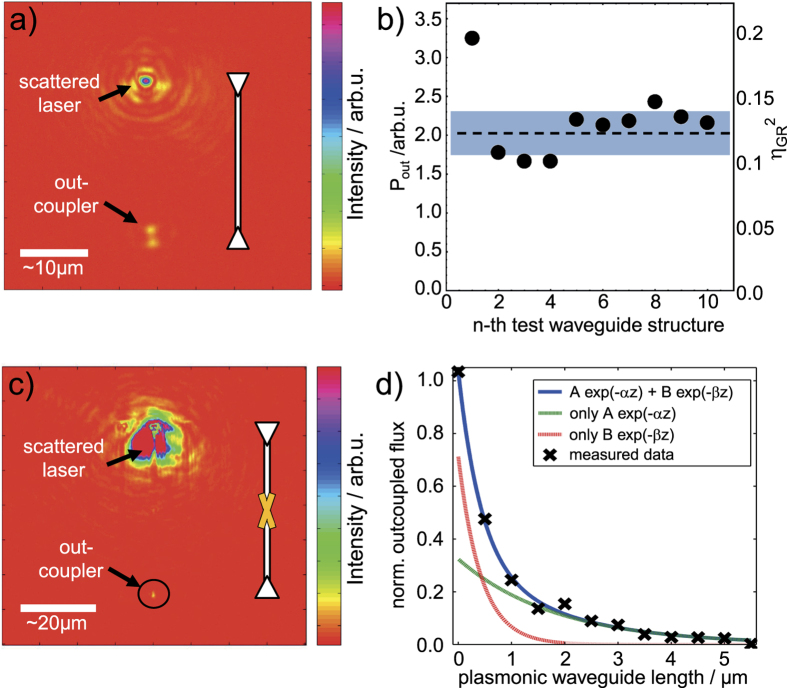
Experimental analysis of grating couplers (a,b) and photon-to-plasmon transducers (c,d) (oriented vertically as depicted by sketch). (a) EMCCD image of a test measurement showing two spots. The upper stems from the scattered excitation laser light at the first grating and the lower from out-coupled light from the ‘out-coupler’ grating. (b) Power Pout (and overall-efficiencies ) measured at the ‘out-coupler’ gratings of ten different test waveguide-structures (without plasmonic elements). The dashed vertical line and the shaded region show the mean value of  = 12.4 ± 1.7% and the uncertainty region of one standard-deviation, respectively. This mean value yields an efficiency of a single grating coupler of ηGR = 35 ± 2%. (c) CCD camera image corresponding to a measurement for estimating the coupling efficiency ηspp of the photon-to-plasmon transducer. The large upper spot stems from scattering of an expanded laser at the first Bragg-grating, the small spot (marked by a black circle) correspond to scattered out-coupled photons from the second Bragg-grating. The distance between two opposing grating couplers is approximately 50 μm. (d) Measured relative out-coupled flux (crosses) as a function of plasmonic waveguide length L. The solid blue curve is a double exponential fit to the signal, showing that typical SPP damping is present. Dashed lines show the contributions of the fast and slowly decaying components, respectively. Fitting the slow decay at zero waveguide length yields a coupling efficiency of ηspp = (57 ± 21)%. The coupling efficiency seems to be high for short length L only due to direct coupling of the photonic waveguides by scattered photons (fitted by the fast exponential decay).